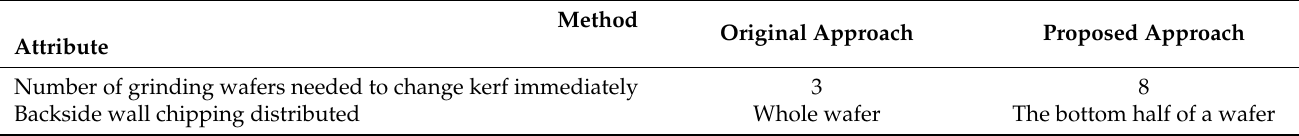
Table 6. Wafer grinding using different